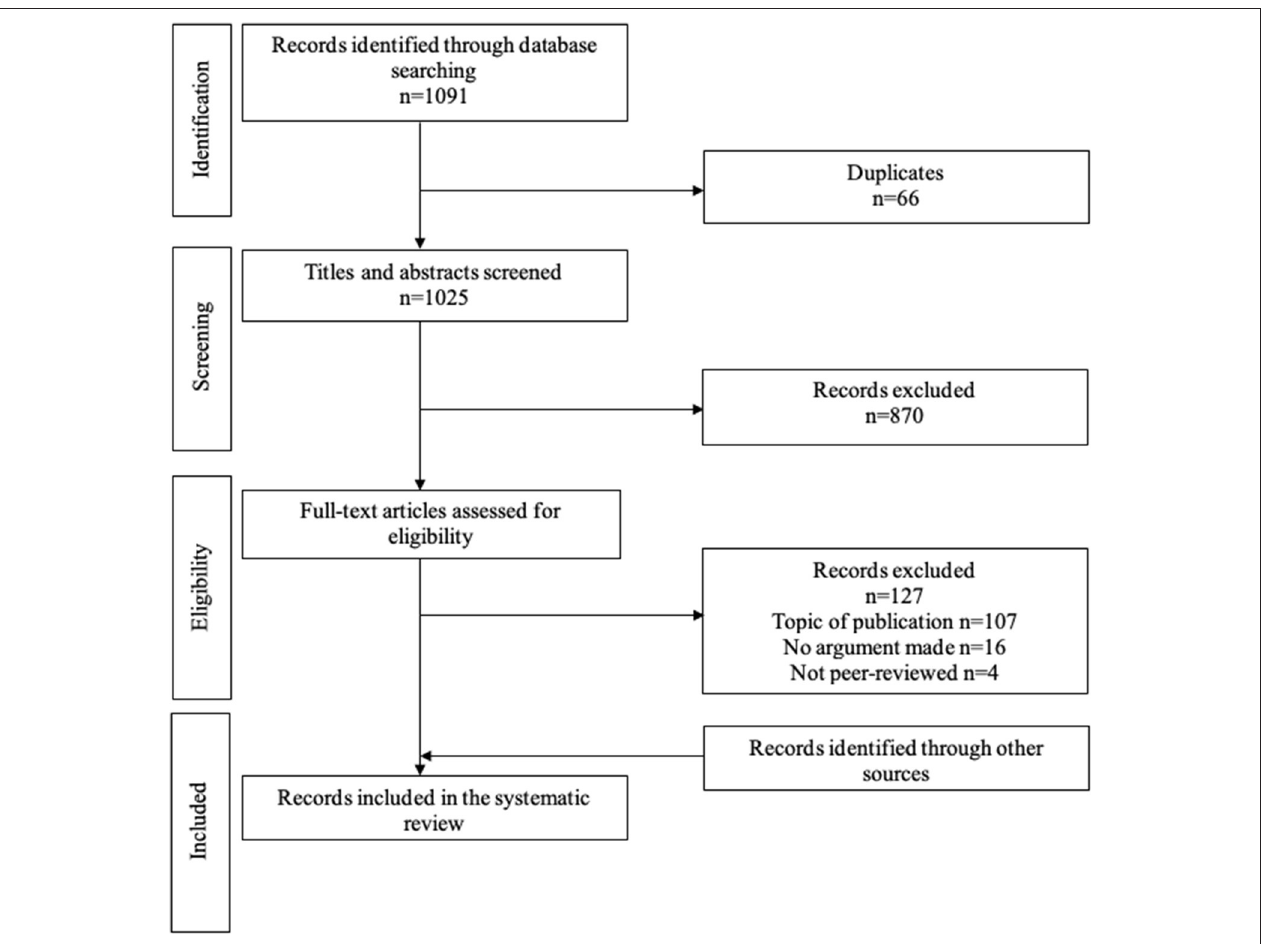
FIGURE 1 | PRISMA flow chart for article